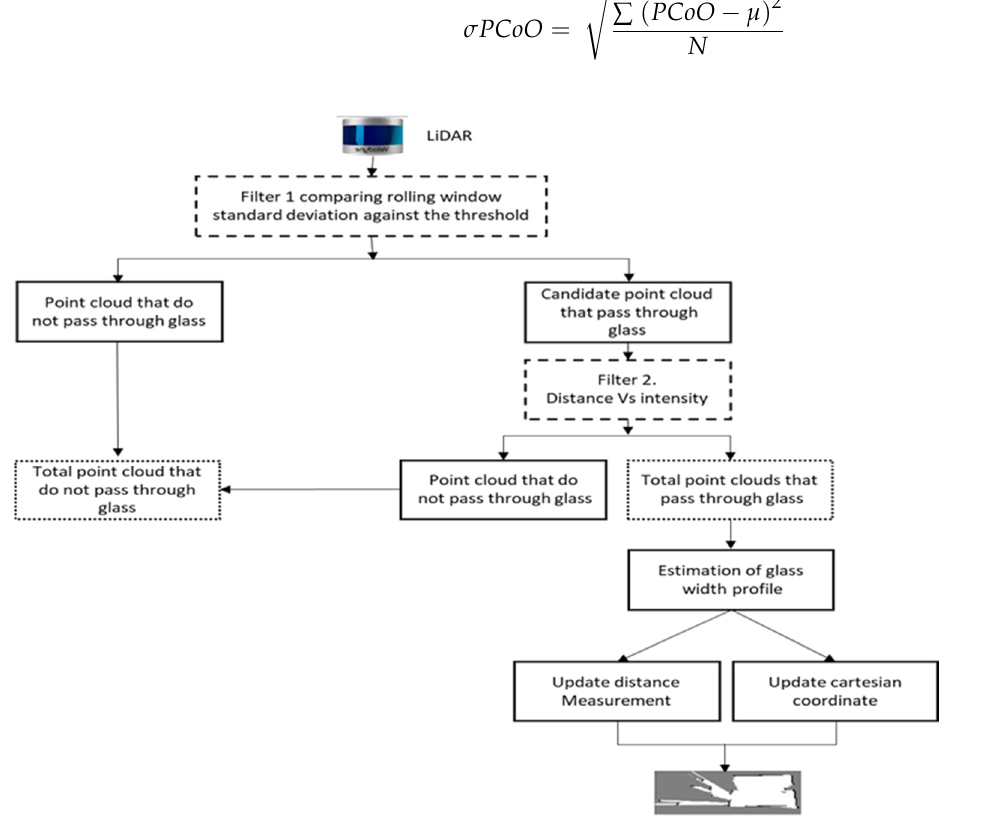
Figure 4. Proposed method layout.